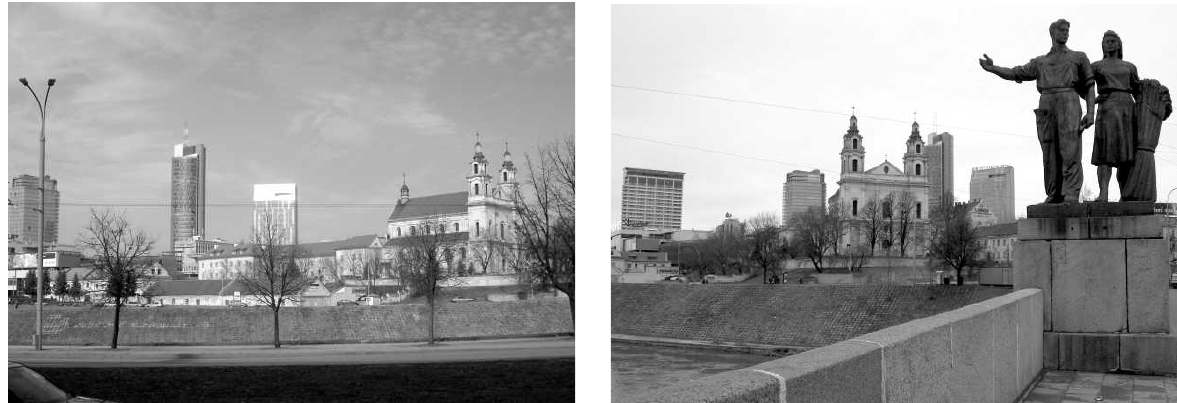
Fig 3. View of the right bank of the Neris. A. Vyšniūnas’ photos, 2006